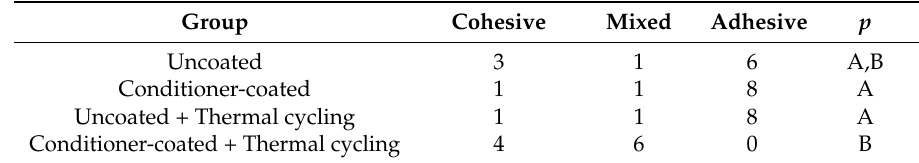
Table 4. Numbers of different failure modes of each group.